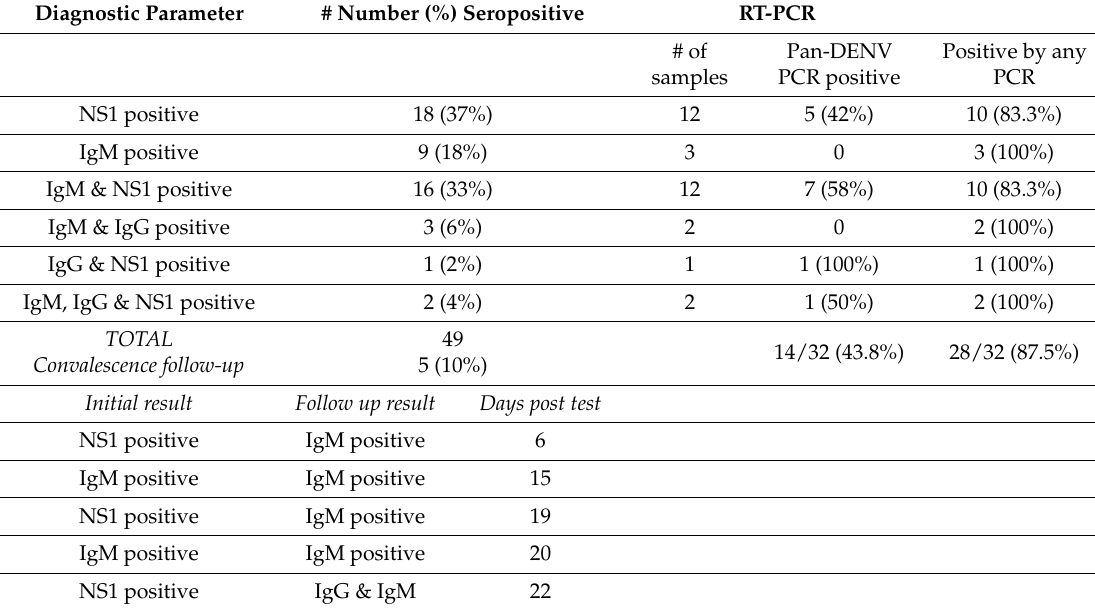
Table 2. Summary of DENV serological and RT-PCR testing in patients who were subsequently diagnosed with DENV ( n = 49, serology; n = 32, RT-PCR) and underwent convalescence follow-up ( n = 5). RT-PCR results are discussed in a later section of the text.